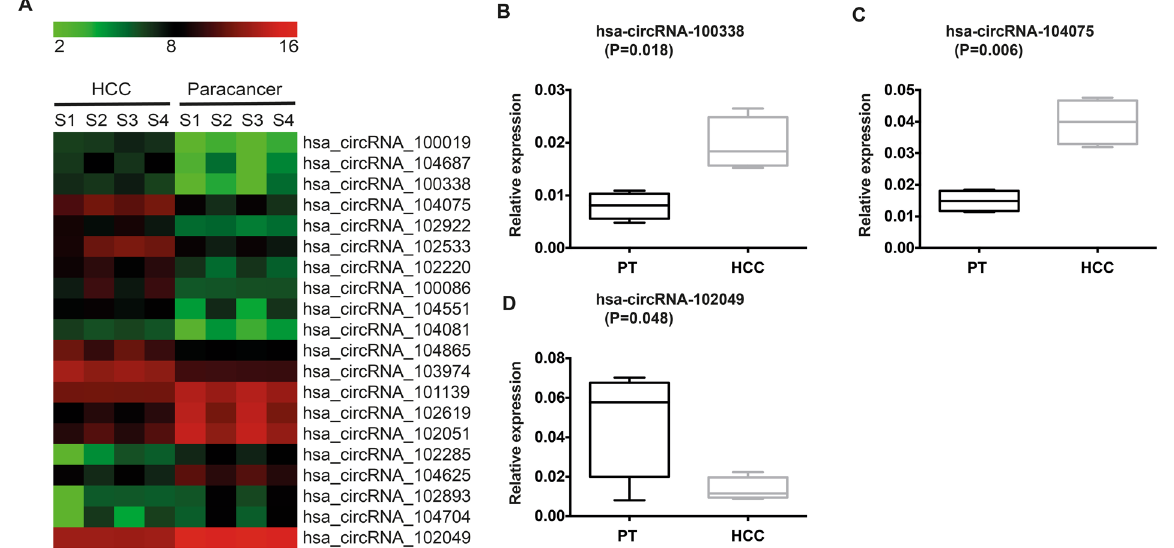
Figure 1. Differential expression of selected circRNAs in HCC and paired pericancerous tissues (PT) samples. ( A ) Based on the circRNA microarray results, the top 12 upregulated and top eight downregulated circRNAs in HCC compared with PT samples are shown in the heatmap. The red colour represents high expression, whereas the green colour represents low expression. ( B – D ) qRT-PCR verification of the expression of ( B )